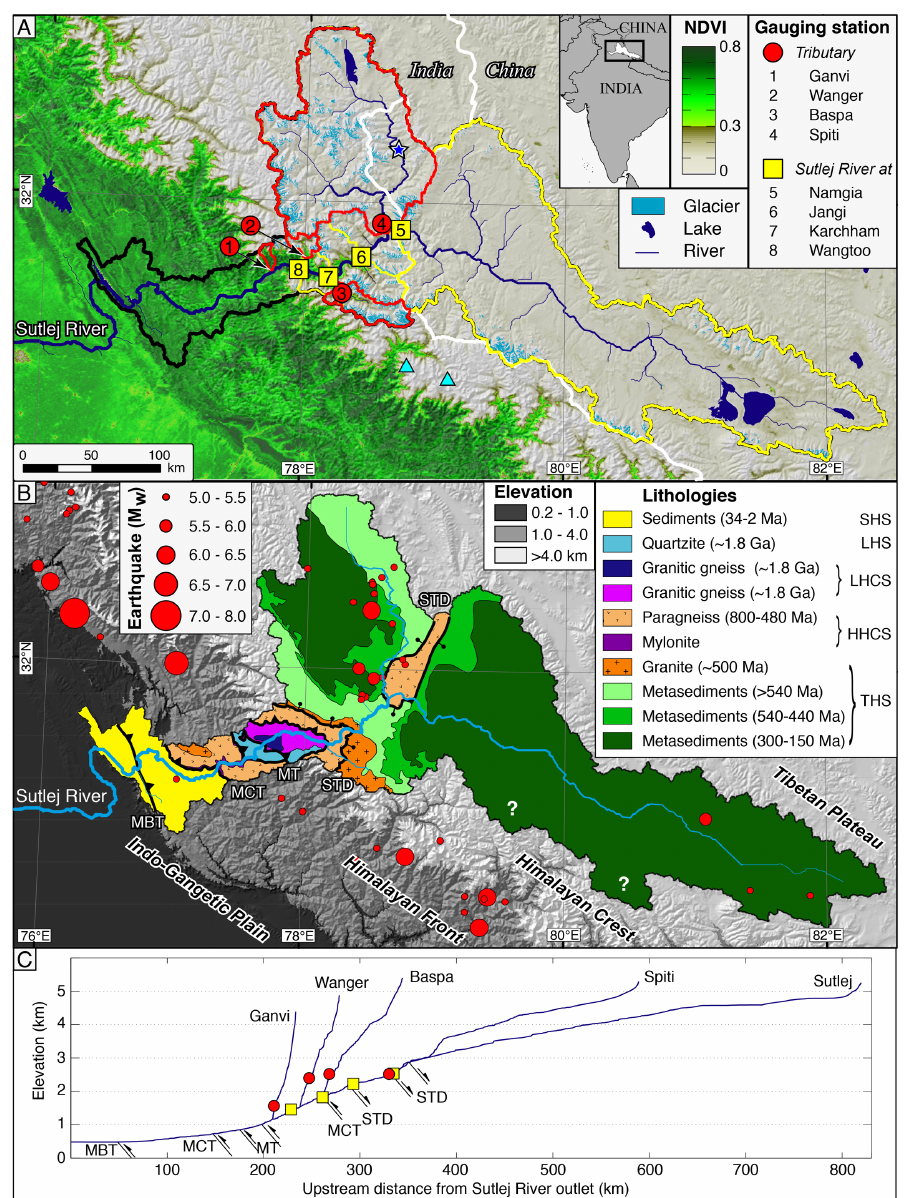
Fig. 1. (A) Map of the study area, showing the normalized difference vegetation index (NDVI) based on MODIS data (Huete et al., 2002), draped over a shaded relief map, and overlain by glaciers, lakes, and the Sutlej River network. Numbers denote gauging stations where river discharge and suspended sediment concentration were measured. The Baspa River (no. 3) joins the Sutlej River downstream of Karchham (nr. 7). The corresponding upstream areas of the Sutlej River and its tributaries are indicated in red and yellow, respectively. The star marks the location of the temporary Parechu Lake, and the triangles indicate the locations of the Dokriani (east) and Gangotri (west) glaciers. The glacial shapefiles are based on Landsat classification data of debris-free ice and manual delineation of debris-covered glacial areas in Google Earth. (B) Geologic units and major tectonic structures (modified after Thiede et al., 2004; Vannay et al., 2004; Webb et al., 2011) within the study area together with earthquake locations (http://www.iris.washington.edu) (Table A2). Lithologies are grouped into the Sub-Himalaya Sequence (SHS), Lesser Himalayan Sequence (LHS), Lesser Himalayan Crystalline Sequence (LHCS), Higher Himalayan Crystalline Sequence (HHCS), and Tethyan Himalayan Sequence (THS). Major tectonic faults along the Sutlej River are indicated by the following abbreviations: MBT (Main Boundary Thrust), MCT (Main Central Thrust), MT (Munsiari Thrust), STD (South Tibetan Detach- ment). Surrounding areas show elevation draped over a shaded-relief map to differentiate different orogenic compartments. (C) Longitudinal river profile of the Sutlej River and its tributaries analyzed in this study. Red circles and yellow squares denote gauging station locations as indicated in (A)